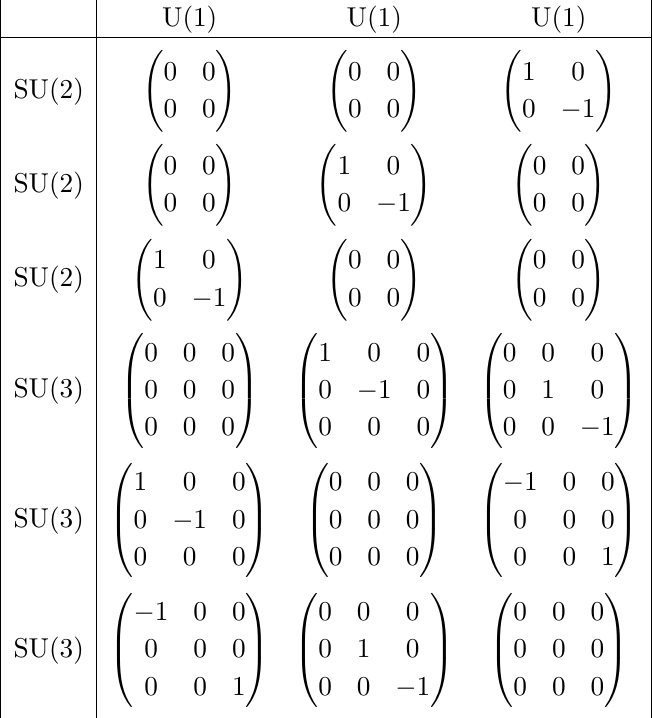
Table 3 . Embedding of U(1) 3 into SU(2) 3 (cid:2) SU(3) 3 . The generator of a given U(1) factor is the sum of the SU( N ) generators in the corresponding